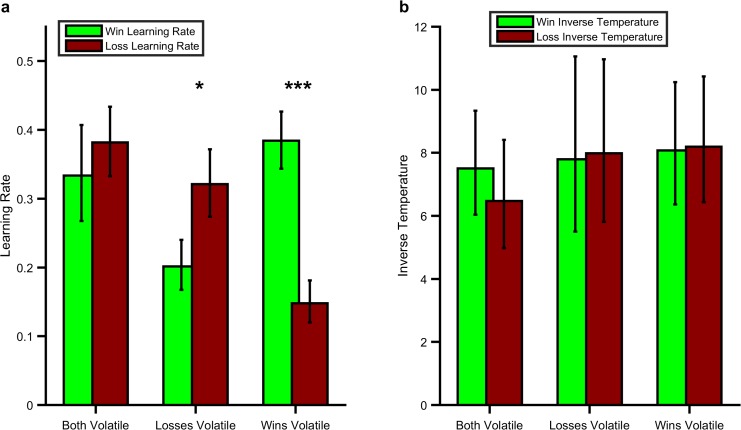
Effect of the Volatility Manipulation on Participant Behaviour.(A) Mean (SEM) learning rates for each block of the learning task. As can be seen the win learning rates (light green bars) and loss learning rate (dark red bars) varied independently as a function of the volatility of the relevant outcome F(1,28) =27.97, p<0.001, with a higher learning rate being used when the outcome was volatile than stable (*p<0.05, ***p<0.001 for pairwise comparisons). (B) No effect of volatility was observed for the inverse temperature parameters (F(1,28) =0.01, p=0.92). Source data available as Figure 2—source data 1. See Figure 2—figure supplement 1 for an analysis of this behavioural effect which does not rely on formal modelling and Figure 2—figure supplement 2 for an additional task which examines the behavioural effect of expected uncertainty.10.7554/eLife.27879.007Figure 2—source data 1.Fitted model parameters, questionnaire measures and mean pupil response to volatility for all participants.